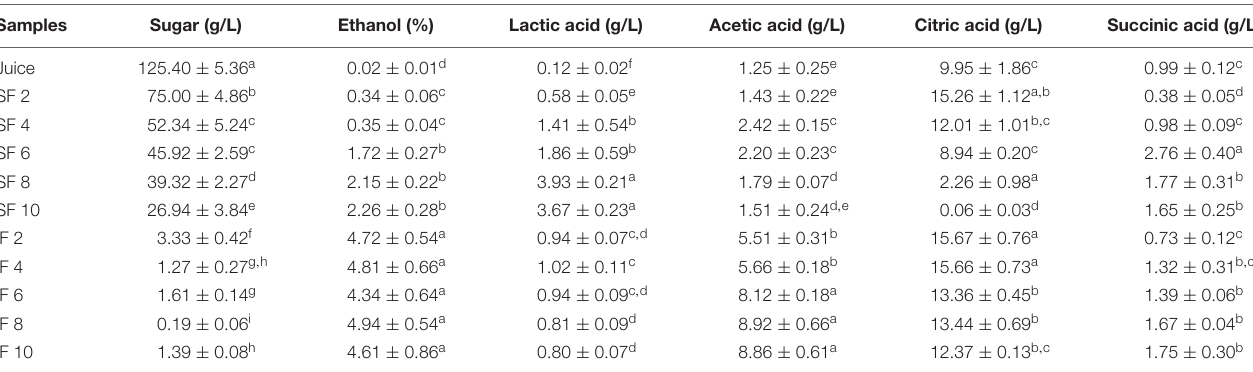
TABLE 2 | Chemical and physical properties of samples at different fermentation stages.